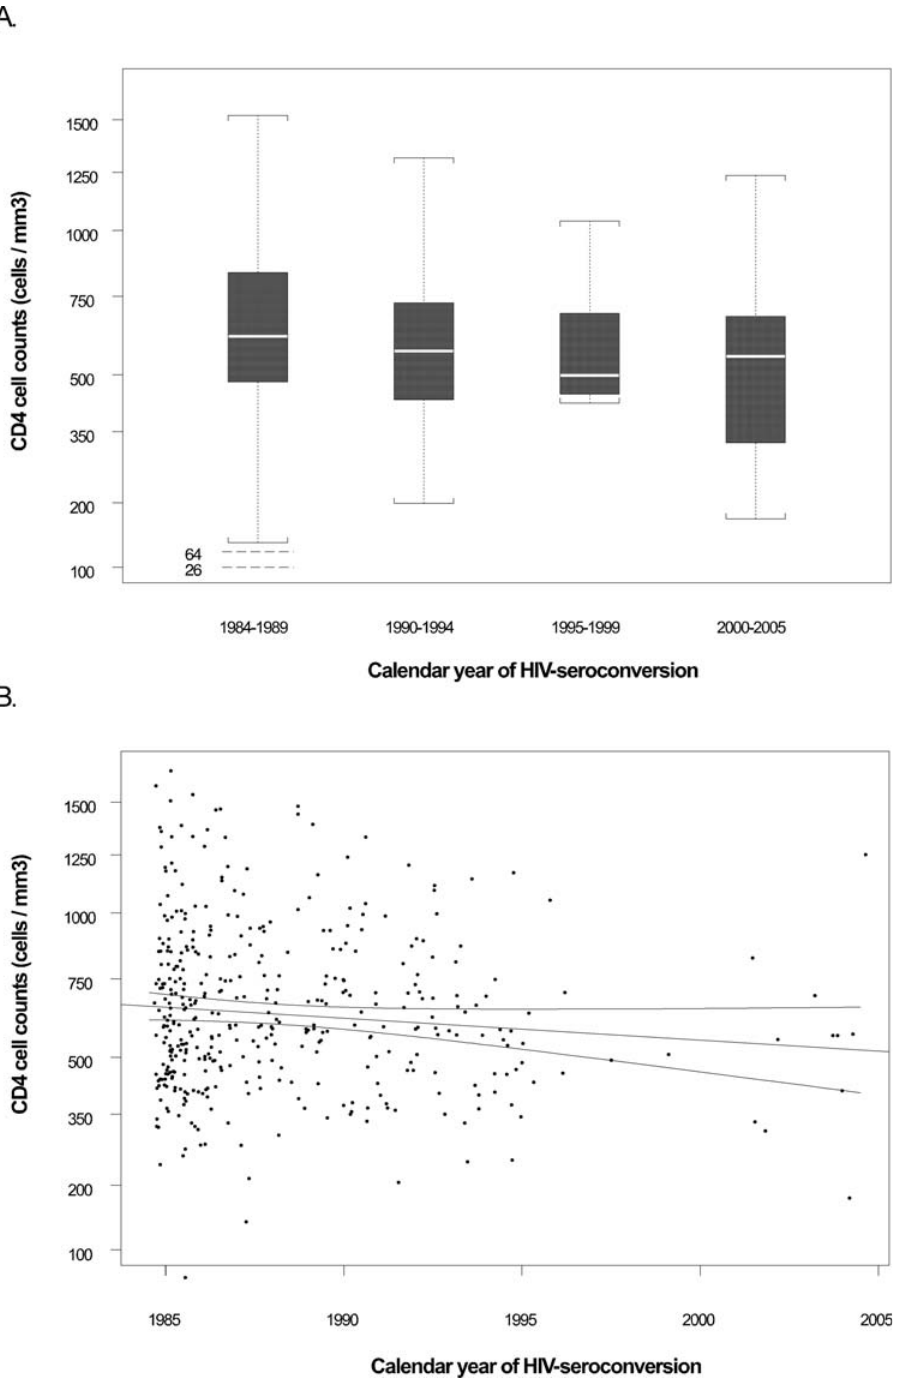
Figure 2. CD4 + T cell levels through time. A) Boxplot for the mean of square-root transformed CD4 + T-cell count at second and third seropositive visits ( , 9 and , 15 months after estimated date of seroconversion) by calendar period of seroconversion. Boxes are defined as in the legend to Figure 1. B) Relationship between the mean of square-root transformed CD4 + T-cell count at second and third seropositive visits and calendar year of seroconversion. Three solid lines are the fitted regression line and its 95% confidence bands from univariate linear regression (note that slope estimates reported in manuscript text are from multivariate analysis). doi:10.1371/journal.pone.0001525.g002 viral load analysis, n= 5 at first seropositive visit, n= 14 at second, impact our analyses. Fourth, we could not correct for the changes in laboratory methods for CD4 or viral load measurements over n =16 at third; for CD4 analysis, n= 6 at first seropositive visit, n =20 at second, n = 18 at third; for CD4 slope analysis, n= 28 in this time period, as the these changes correlate completely with the first three years after seroconversion), and this likely did not year (and we are looking for changes in estimates of these markers